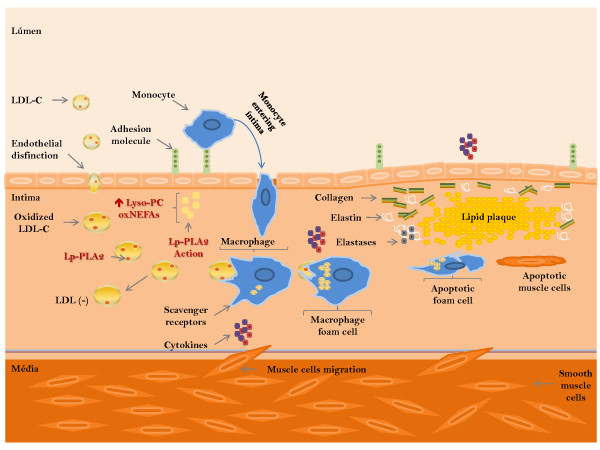
Possible actions of Lp-PLA2 in the atherosclerotic process.